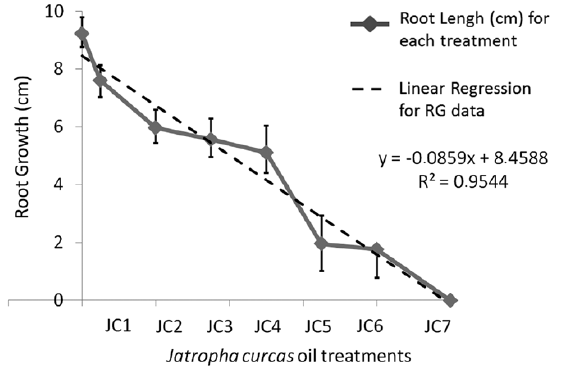
Figure 1 - Root Growth curve in L. sativa after J. curcas oil exposure Means with (*) represent statistically significant differences ( P < 0.05) relative to control according to kruskal– Wallis test. Bars indicate standard deviation.